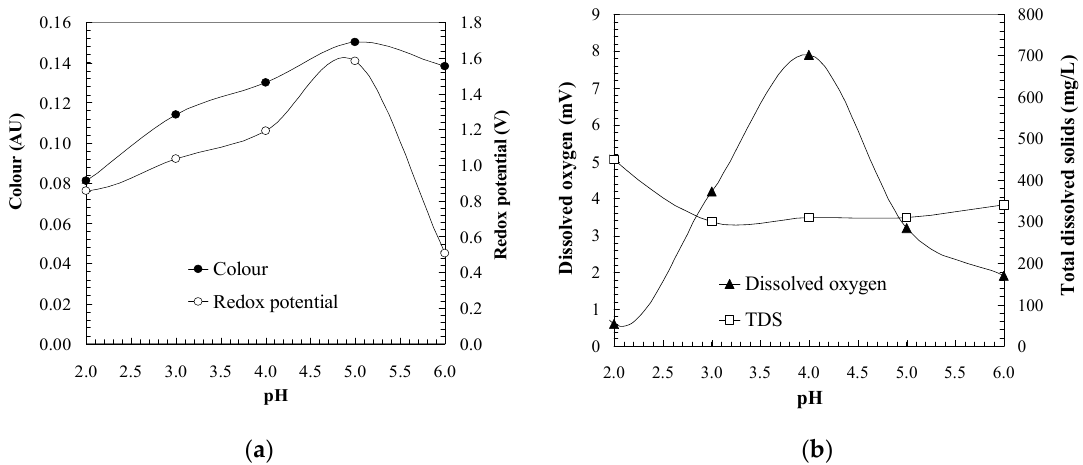
Figure 3. Indicator parameters of water quality analysed at the steady state: ( a ) Colour and redox potential. ( b ) Dissolved oxygen and total dissolved solids. Experimental conditions: [CBZ] 0 = 50.0 mg/L; [H 2 O 2 ] 0 = 15.0 mM; [Fe] 0 = 10.0 mg/L; [UV] = 150 W; T = 40 °C.